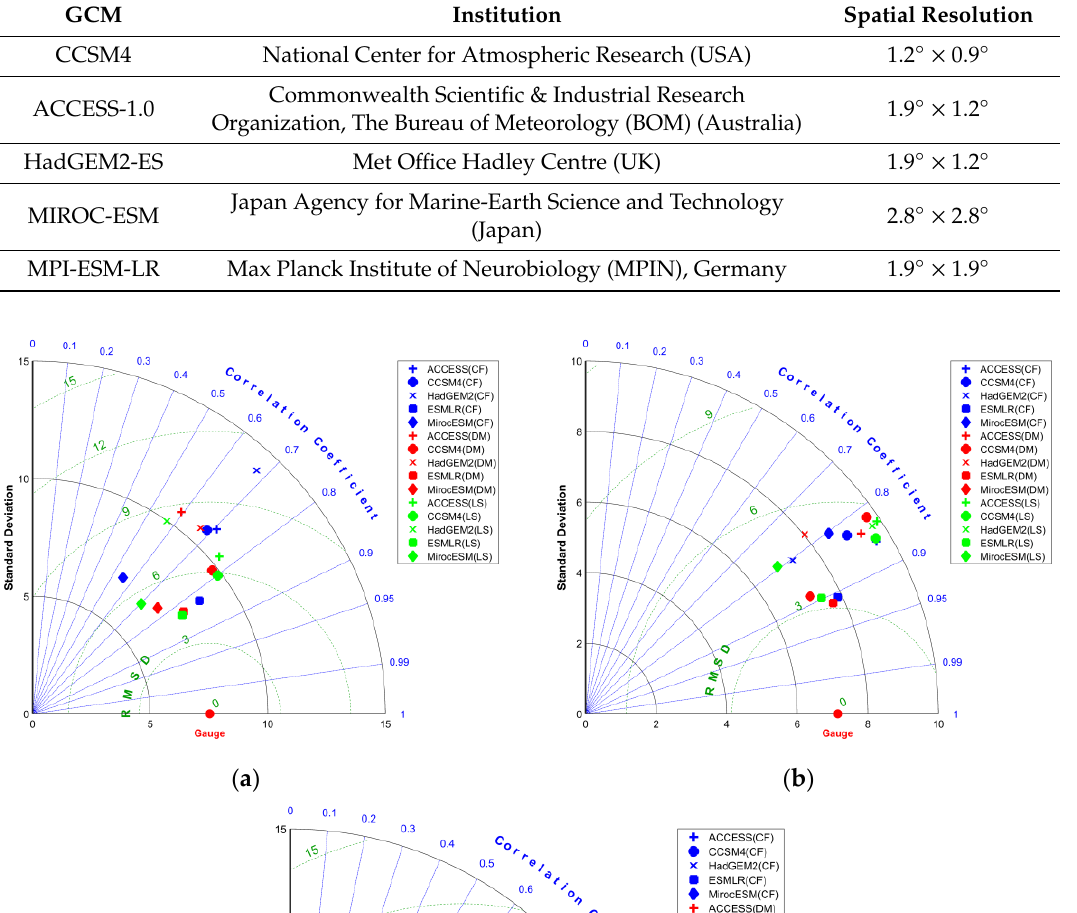
Table 3. Description of the selected global climatic model used in this research.